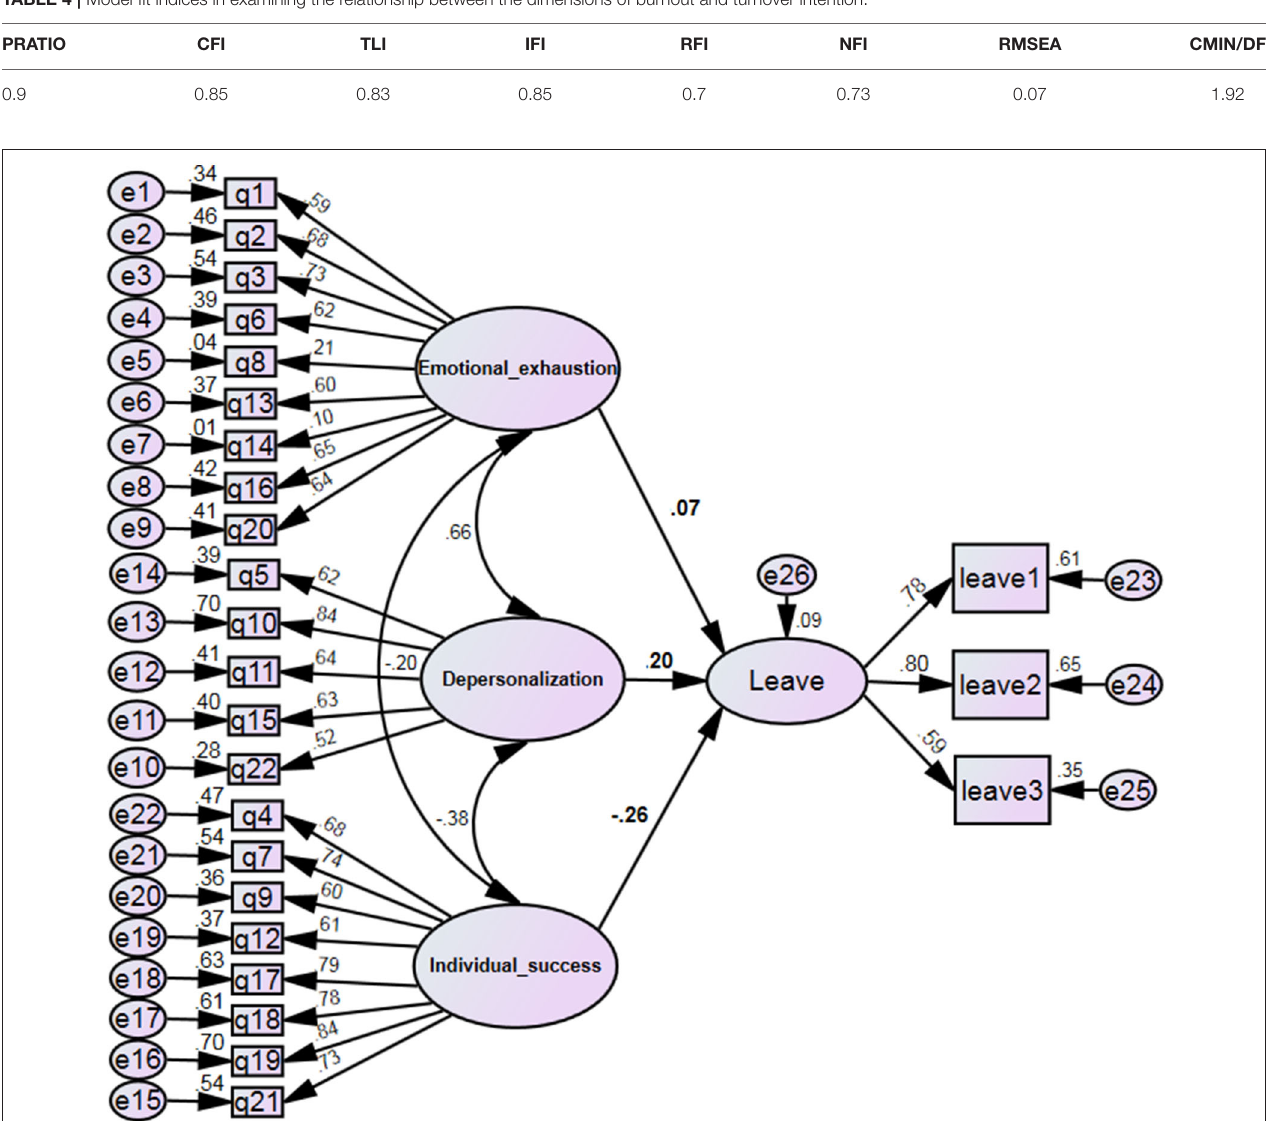
TABLE 4 | Model fit indices in examining the relationship between the dimensions of burnout and turnover intention.